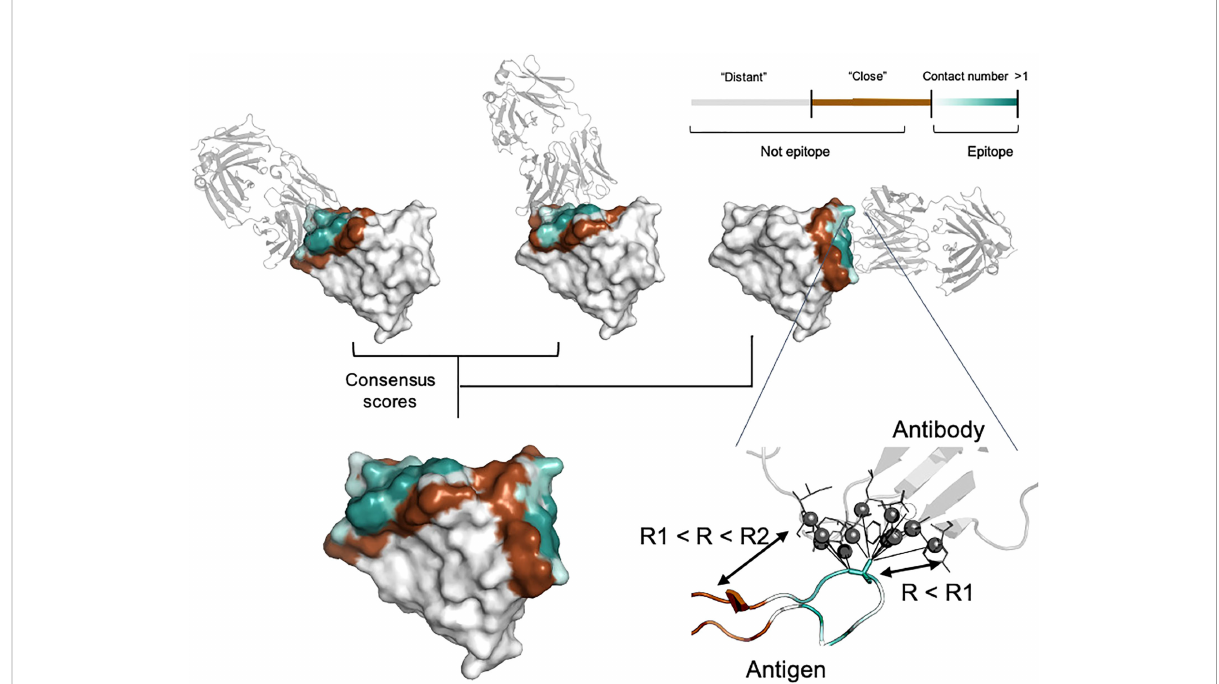
FIGURE 1 Epitope data set generation. For each residue, the contact number interaction feature was calculated, which corresponds to the log-scaled number of contacts of antigen residues with antibody residues within the radius R 1. Antigen residues within R 1 and R 2 distance of the antibody were classi fi ed as non-epitope (brown color). Residues located further away than R 2 were either considered as non-epitope (the “ unmasked ” data set) or ignored in the model training and and calculation of the relevant metrics (the “ masked ” data set, highlighted in gray). The color gradient from light cyan to dark cyan corresponds to the contact number value ranked from low to high, respectively. The color map is shown in the top right-hand corner of the fi gure. Epitopes obtained from distinct antigen-antibody complexes from the PDB database were merged to provide the fi nal antigen epitopes data